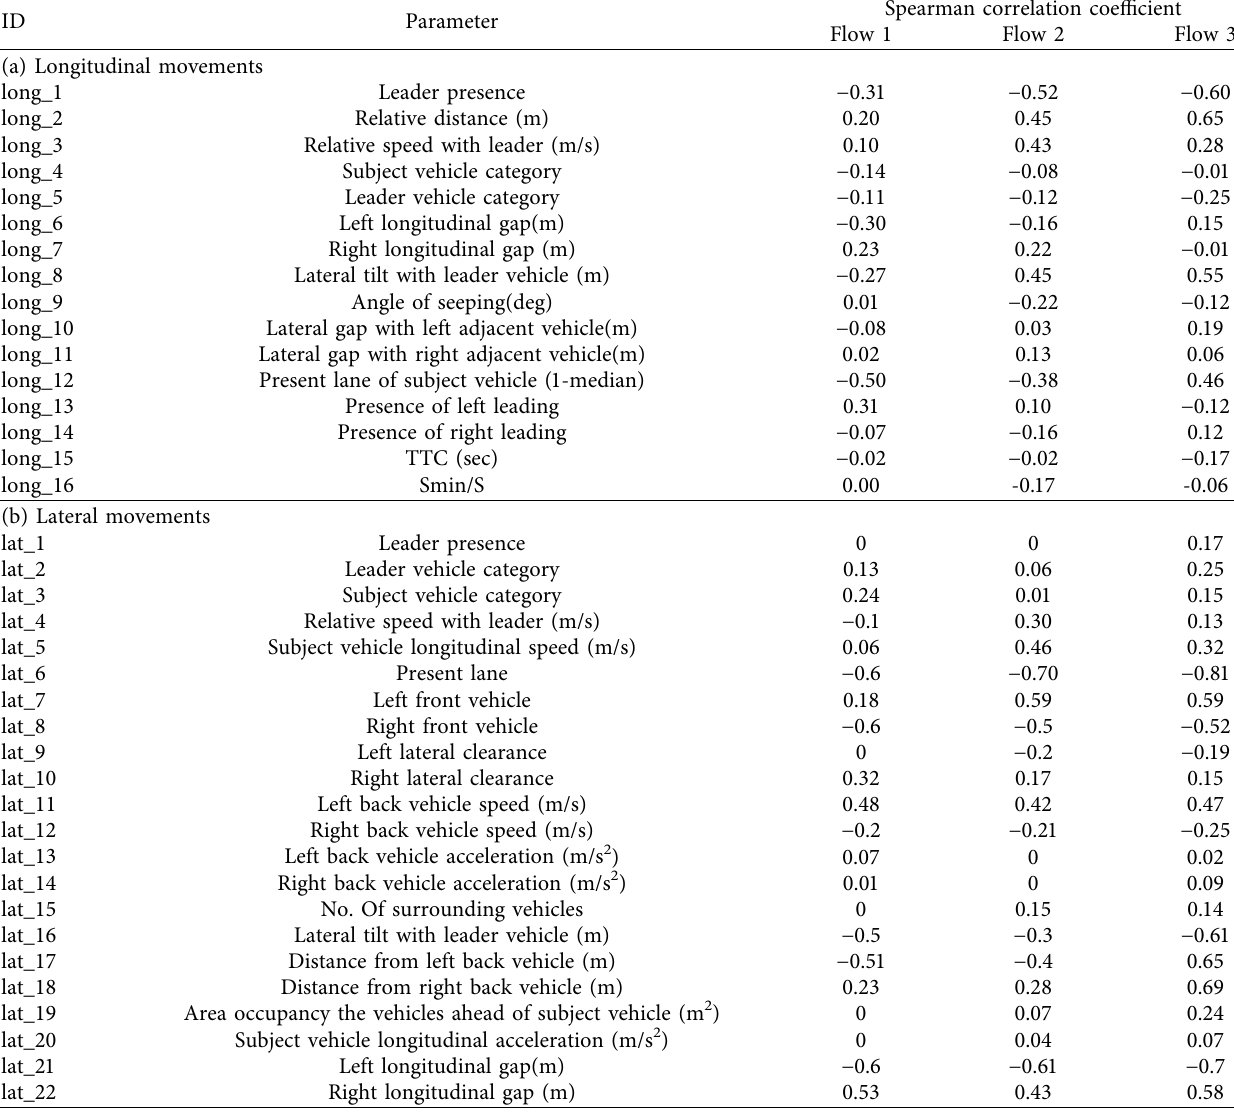
Table 3: Spearman correlation coefficient for different flow